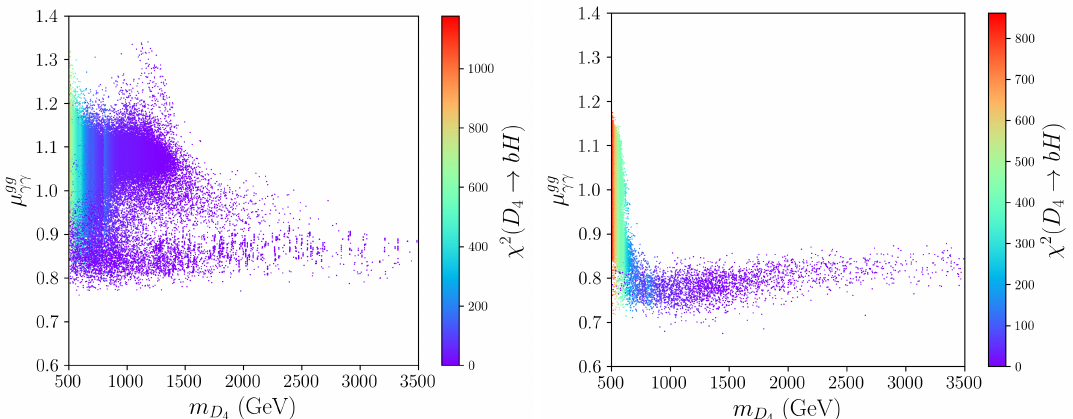
and the mass of the lightest down- Figure 17. Relationship between the Higgs signal strength µ gg γγ type resonance in ( left ) the M4DCHM 5 − 5 − 5 , and ( right ) the M4DCHM 14 − 14 − 10 . Points included here satisfy all constraints, excluding the collider constraints and Higgs signal strength constraints, at the 3 σ level. The colour indicates the χ 2 contribution from the D → bH collider